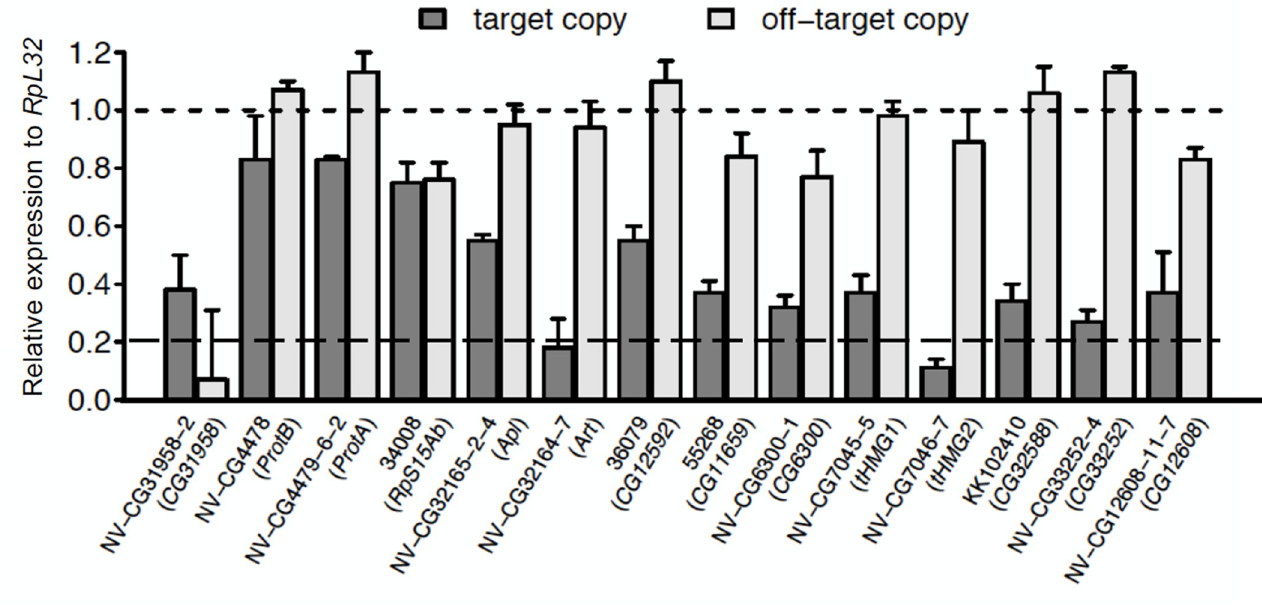
Fig 3. Experimental comparison of the efficiency and off-target effects explain the conservative nature of RNAi knockdown experiments and limited off- targets propensity. For each young duplicate gene pair specific for D . melanogaster and melanogaster species complex, we examined their expression intensity relative to the wide type control (relative expression level to WT normalized by RpL32 ) in whole body flies with qPCR. Only two lines likely produce off-target effects (NV-CG31958, 34008 (the TRiP line)), for both of which the expression of paralog is down-regulated to similar or even lower level compared to the corresponding gene of interest. However, the 34008 line have so low knockdown efficiency that no phenotypic effects can be expected. The standard deviation is calculated based on three replicates.